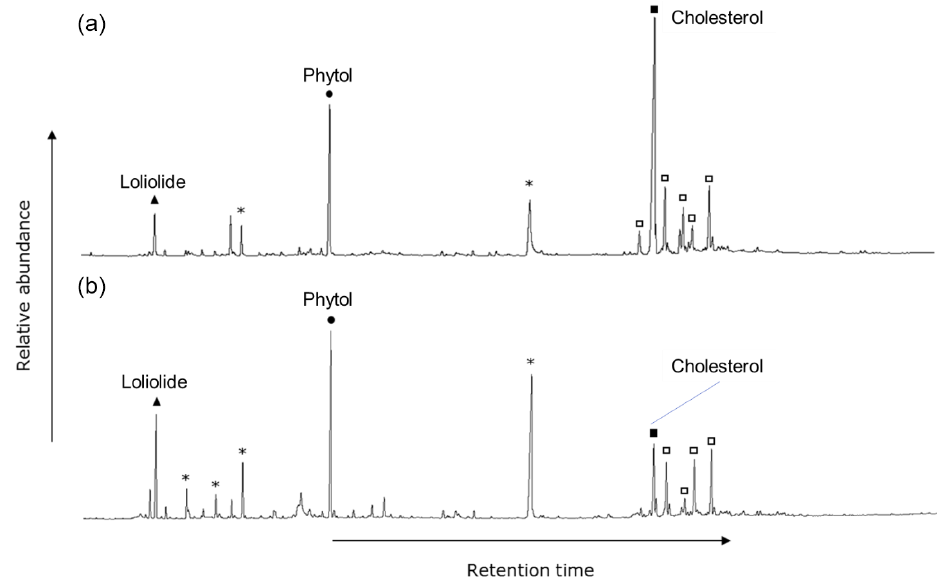
Figure 2. GC-FID trace of silylated polar fraction. June sediment collected at the (a) control site and (b) CO 2 vent, showing saturated fatty alcohols (asterisks) and sterols (squares), and the representative compounds found among all sample matrices, seasons, and CO 2 concentrations: loliolide, phytol, and